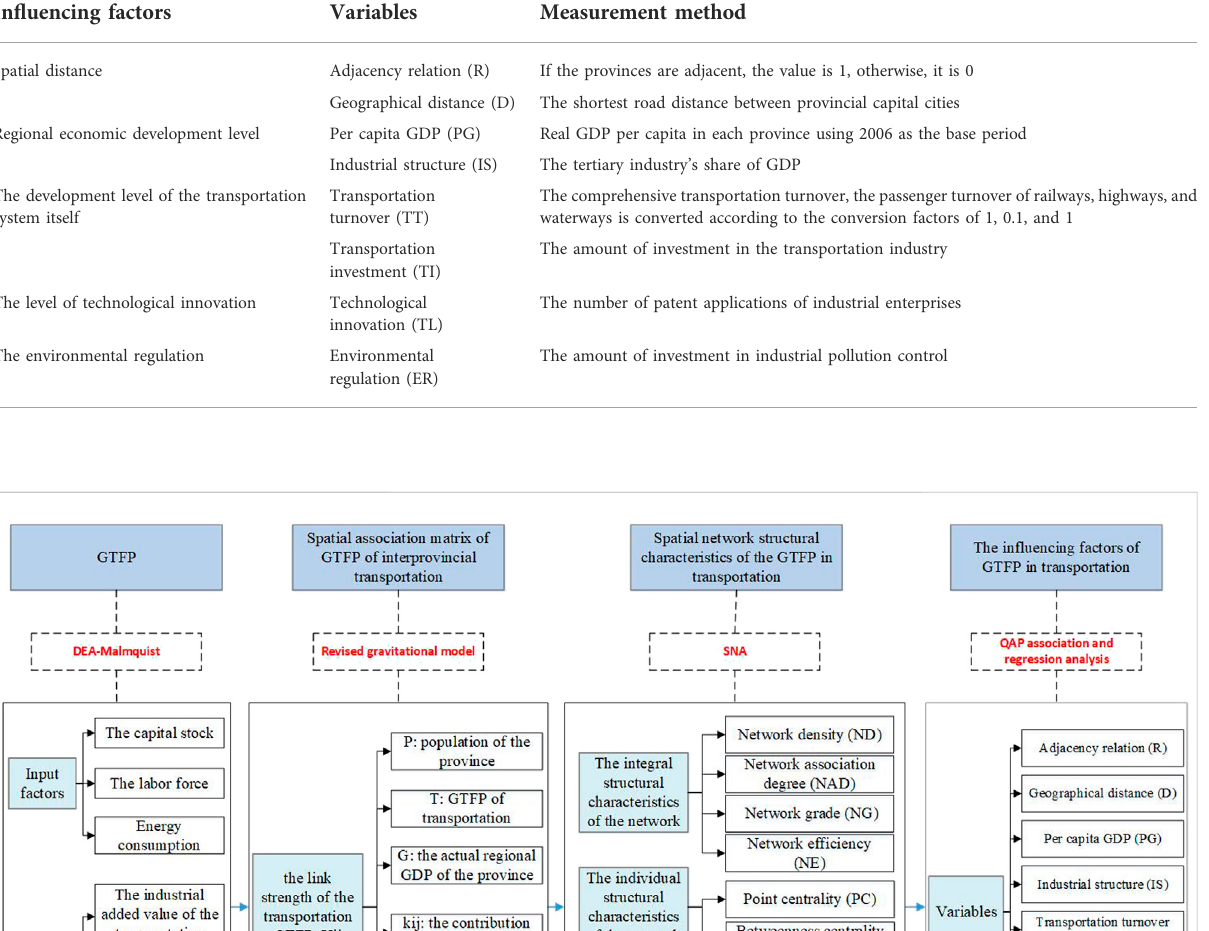
TABLE 1 In fl uencing factors and variable description of the spatial associated network of China ’ s transportation GTFP .